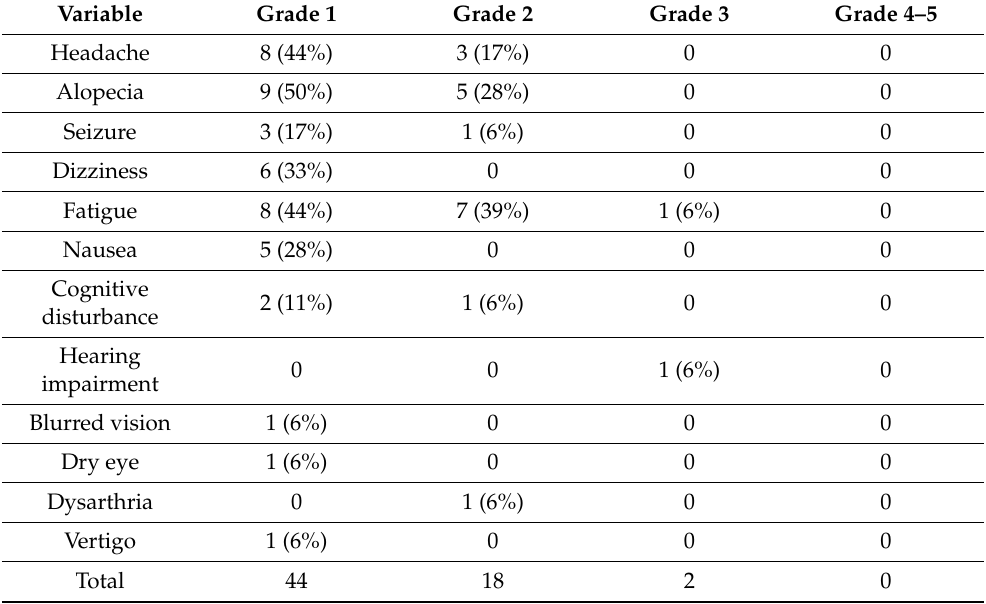
Table 3. Acute or late side